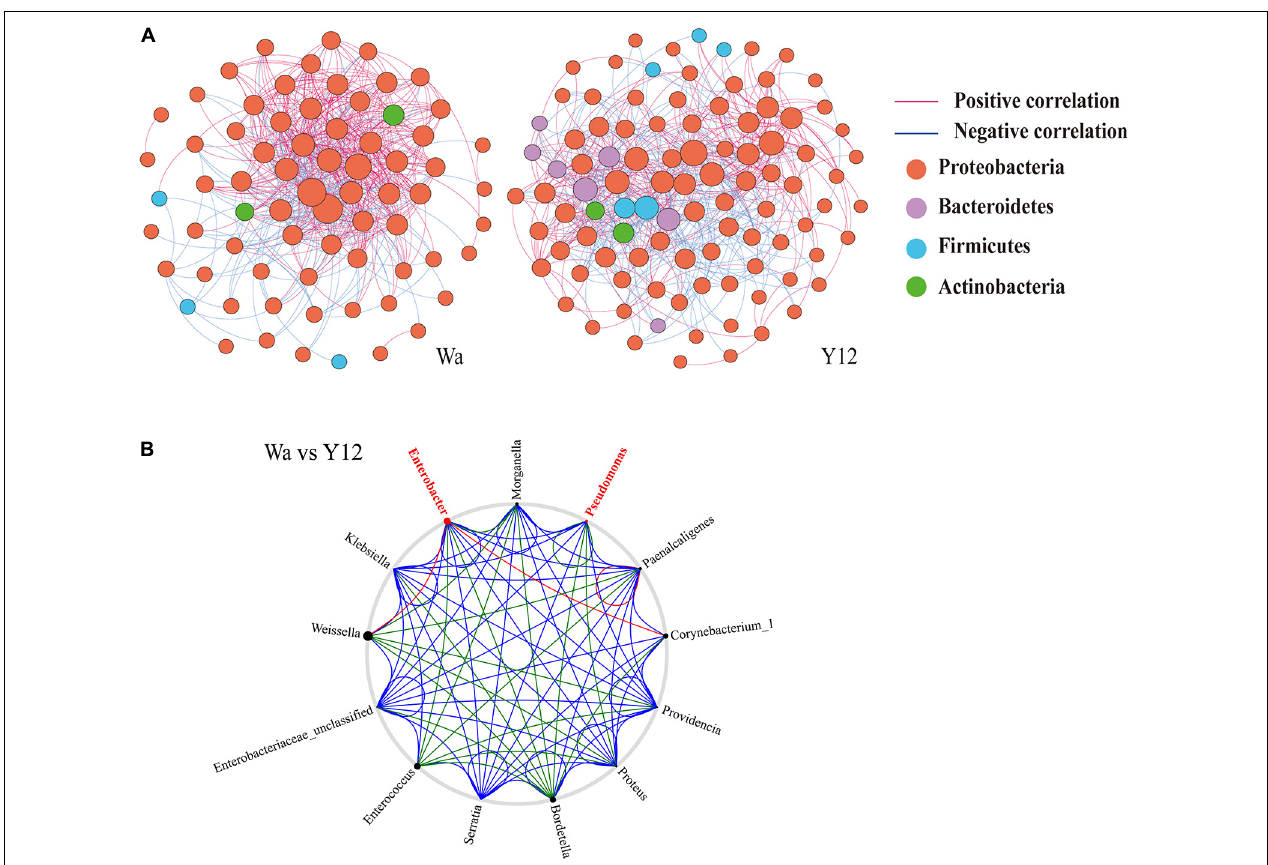
FIGURE 6 | Networks (A) and co-occurrence networks (B) based on intragroup and intergroup intestinal microbiomes. (A) Network analysis of the control group and P. aeruginosa Y12 group. Each point in the figure represents a species, and species with correlations are connected by a line. Red lines represent positive correlations, blue lines represent negative correlations, and the intensity of the line represents the level of correlation. (B) Potential “driver taxa” of infection based on bacterial network analysis of the Y12 experimental groups and the control group W, marked as Y12-W. Node sizes are proportional to their scaled NESH (neighbor shift) score (a score identifying important microbial taxa of microbial association networks), and the nodes colored red are important driver taxa. As a result, large red nodes denote particularly important taxa driving feeding on P. aeruginosa . Line colors indicate node (taxa) connections as follows: association present in only experimental groups (red edges), association present in only the control group (green edges), and association present in both experimental and control groups (blue